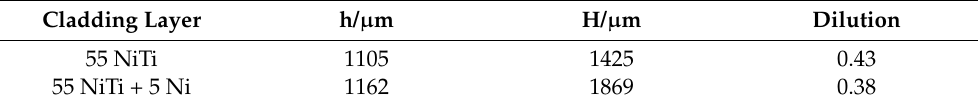
Table 3. Dilution result of the cladding layers. Cladding